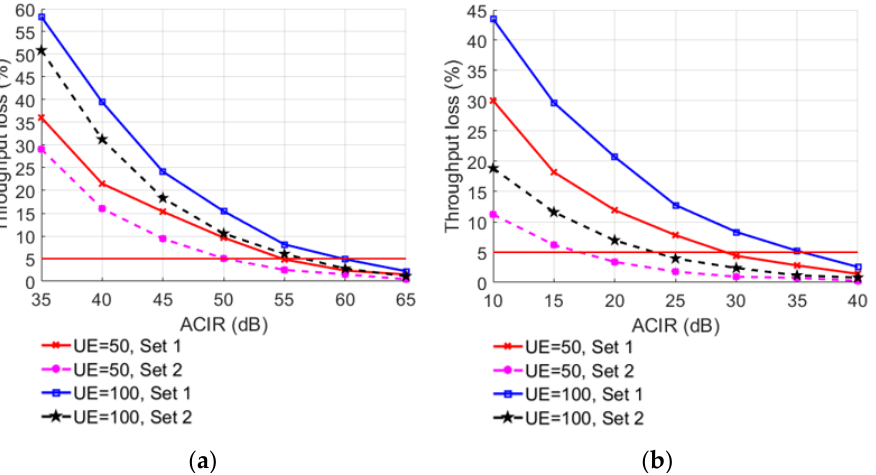
Figure 12. LTE-M throughput loss under different number of users, ACIR, and power control pa- rameter sets: ( a ) UE-BS, ( b ) UE-TE. parameter sets: ( a ) UE-BS, ( b )